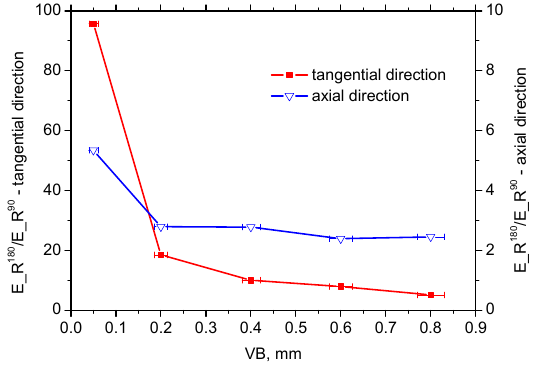
Figure 18. E_R 180 /E_R 90 along with VB, 4.5 for HT.